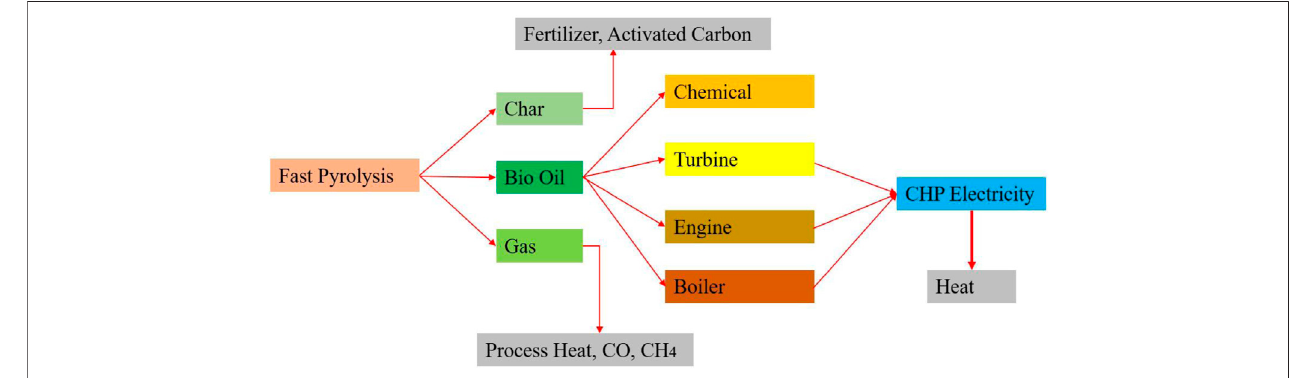
FIGURE 1 | Products of fast pyrolysis of